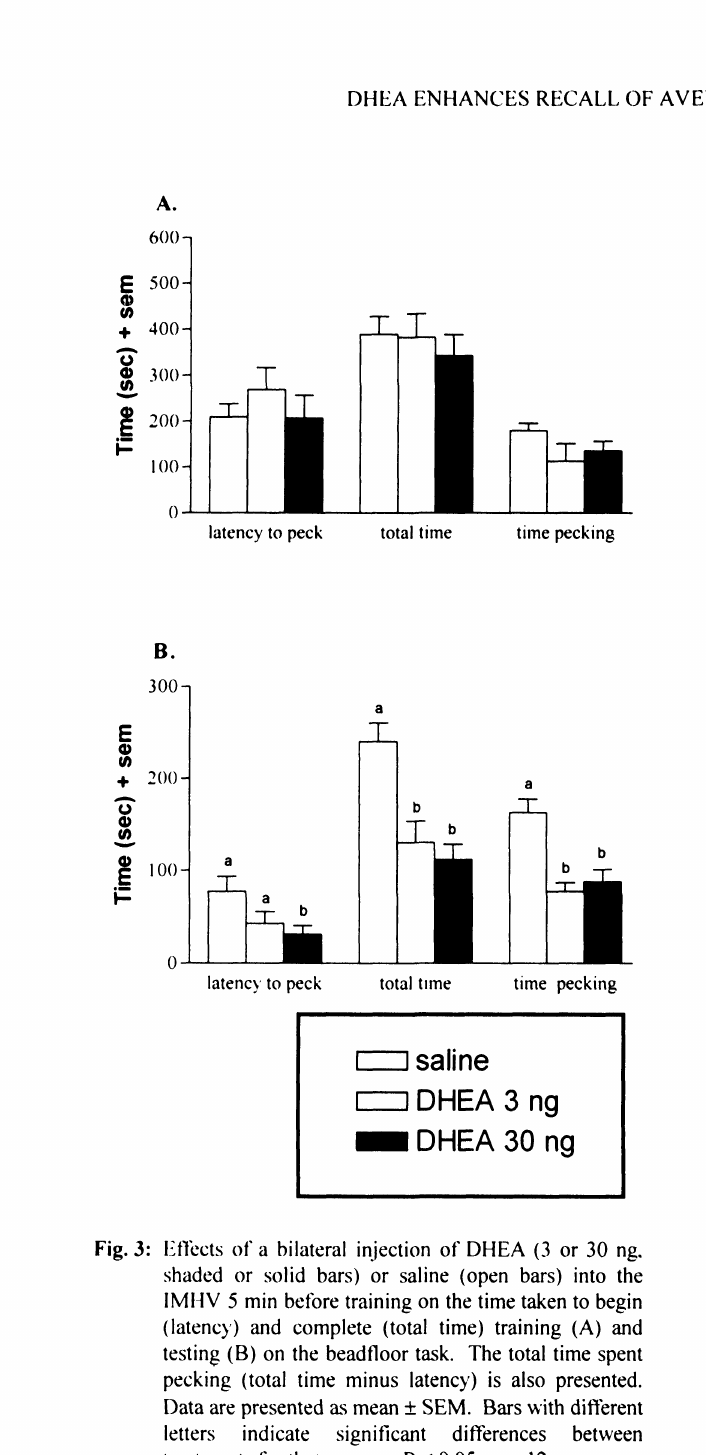
Fig. 3: Eflizcts of a bilateral injection of DHEA (3 or 30 ng. shaded or solid bars) or saline (open bars) into the IMHV 5 min belbre training on the time taken to begin (latency) and complete (total time) training (A) and testing (B) on the beadfloor task. The total time spent pecking (total time minus latency) is also presented. Data are presented as mean + SEM. Bars with different letters indicate significant differences between treatments tbr that measure P < 0.05. n 12 per